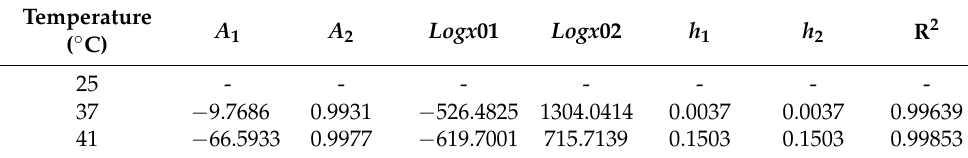
Table 2. Parameters of model 2, the two ‐ stage model (BiDoseResp).